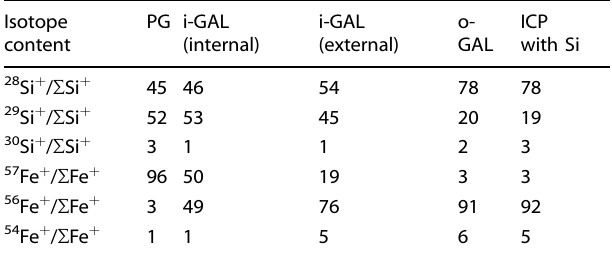
Table 5. ToF-SIMS isotope content in percent (±2 for Si contents, ±0.2 for Fe contents) from the PG, i-GAL (internal and external), o-GAL (regions identi fi ed by the white rectangles from Figs. 2b and 6), and from ICP containing silicon (right side).